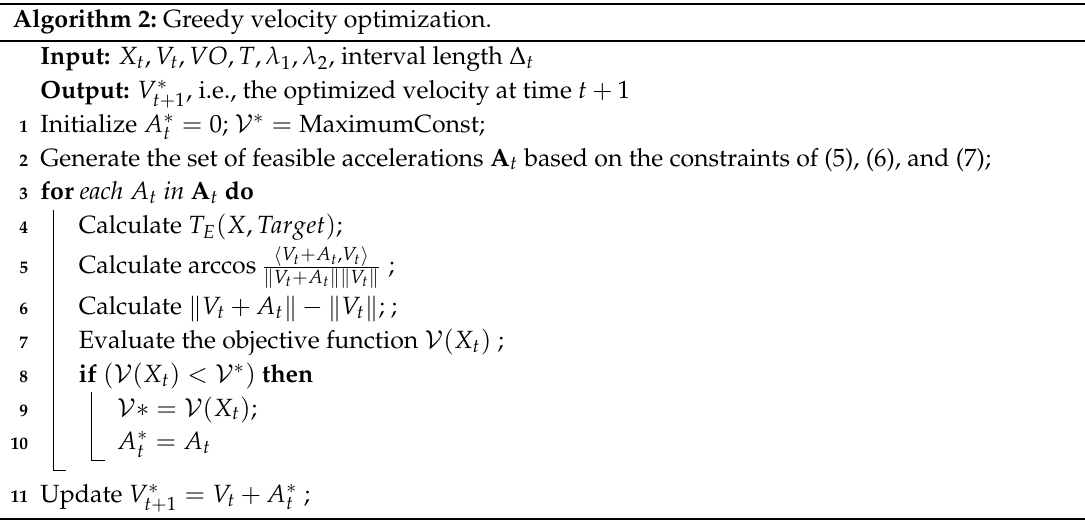
Algorithm 2: Greedy velocity